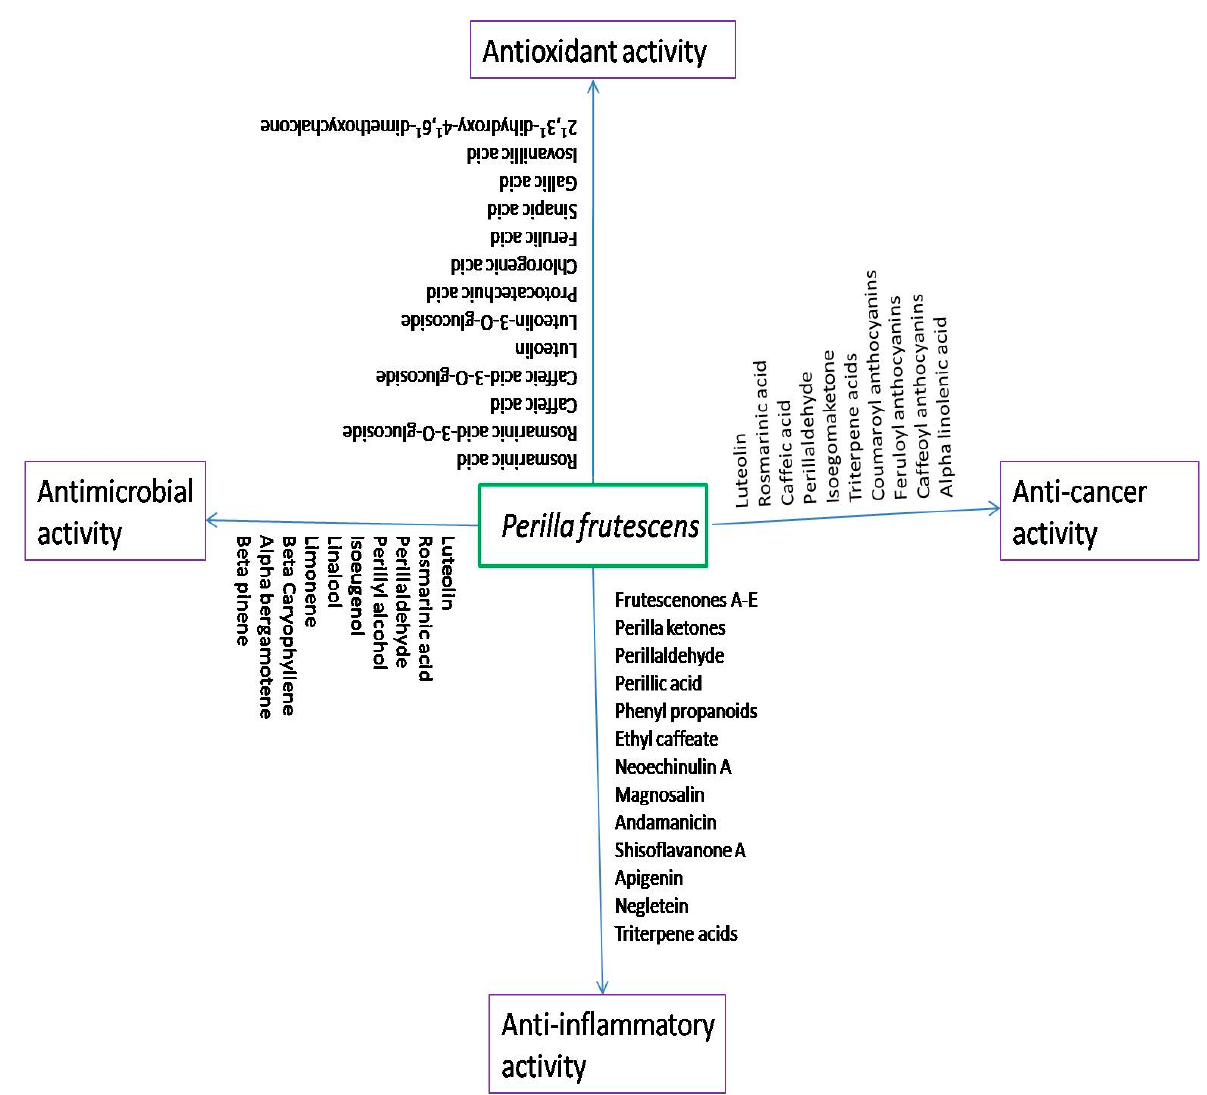
Figure 3. Various bioactive compounds of P. frutescens , exhibiting different biological functions, including antioxidant, anti-inflammatory, anticancer, and antimicrobial activities. Huang et al. [104] reported that the methanolic leaf extract of P. frutescens exhibited anti-inflammatory activity in lipopolysaccharide (LPS)-stimulated macrophage (RAW264.7) cells, which ameliorates LPS-induced inflammation, by downregulating the mRNA ex- pression levels of proinflammatory markers (IL-2, IL-6, and TNF- α ) and inflammatory mediators (iNOS and COX-2). Their study, also, elucidated the underlying mechanism of inhibition of proinflammatory markers and inflammatory mediators. Phosphorylation of MAPKs (ERK1/2, JNK, and p38) and nuclear translocation of NF- κ B are the two main factors associated with the production and expression of proinflammatory cytokines and inflammatory mediators. P. frutescens leaf extract inhibits MAPK phosphorylation, nuclear translocation of NF- κ B, and cytosolic IkB α degradation, in LPS-stimulated macrophages. Chang et al. [84] reported that P. frutescens oil, rich in α -linolenic acid, suppresses